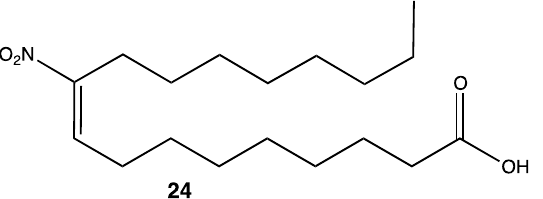
Figure 10. Nitrated fatty acid with anti-inflammatory activity [38].